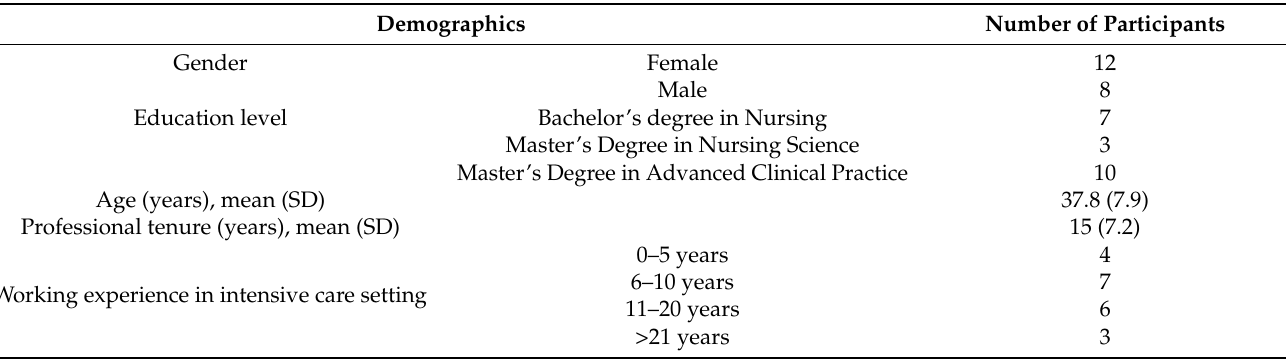
Table 2. Sociodemographic data of interviewed nurses.